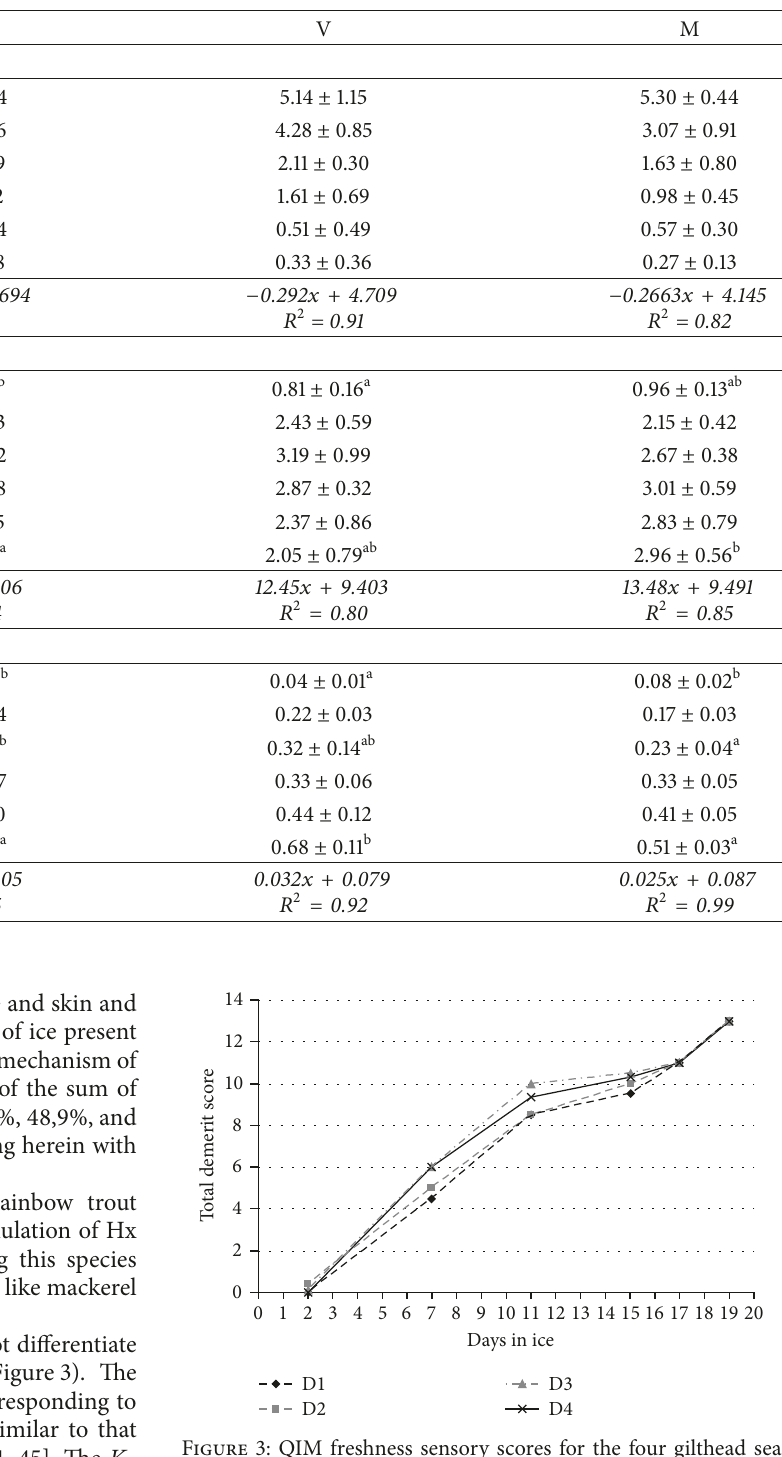
Table 6: Individual ATP breakdown product concentrations in 𝜇 molg −1 fish fillet in rainbow trout fed with the three experimental diets (C, M, and V). Data are mean ± SD (𝑛 = 5) . Means not sharing a common superscript letter are significantly different (𝑝 < 0.05) . IMP: inosine monophosphate; Ino: inosine; Hx: hypoxanthine.